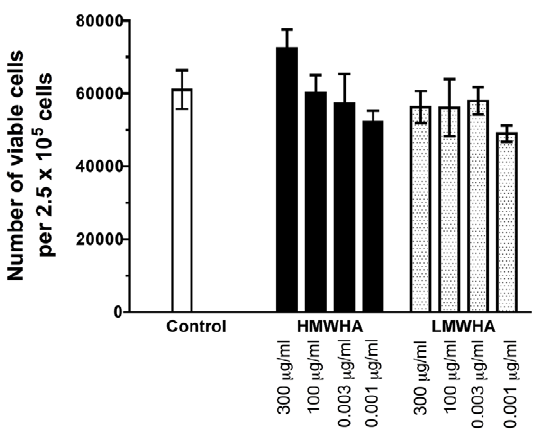
Figure 2. HMWHA and LMWHA do not affect cell viability. Human PBMC were cultured in the absence (SFM) or presence of the indicated concentrations of HMWHA or LMWHA for 5 days. After 5 days, the number of cells was counted. The results are mean 6 SEM of viable cells per 0.15 mm 2 (n=4 separate experiments). There was no statistical significance as analyzed by ANOVA or t-test.